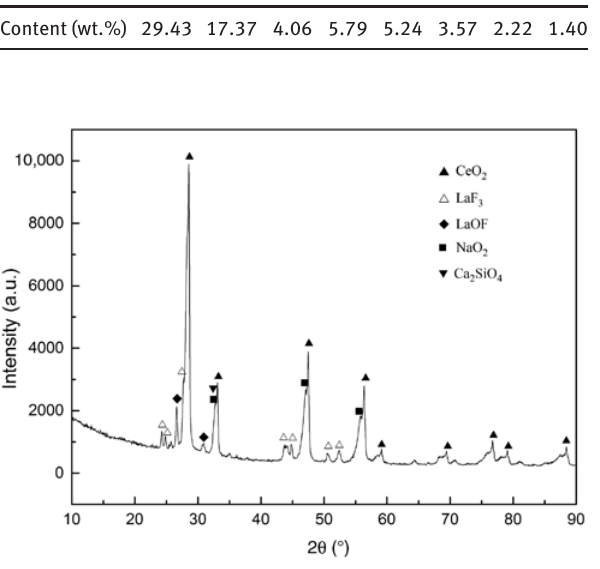
Figure 2: Experimental process of extracting cerium from the waste polishing powder. Figure 1: X-ray diffraction patterns of the raw materials.